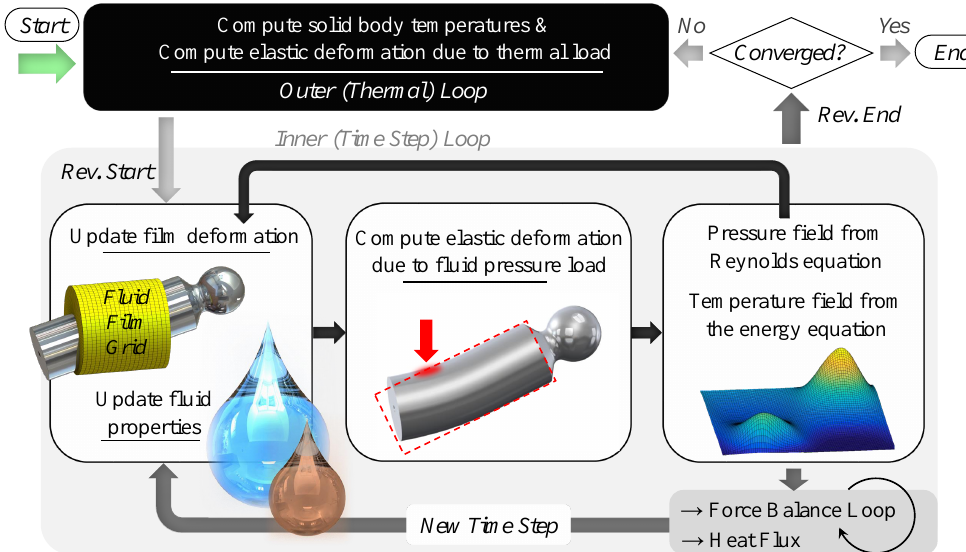
Figure 5. Maha Fluid Power Research Center in-house fluid–structure–thermal interaction